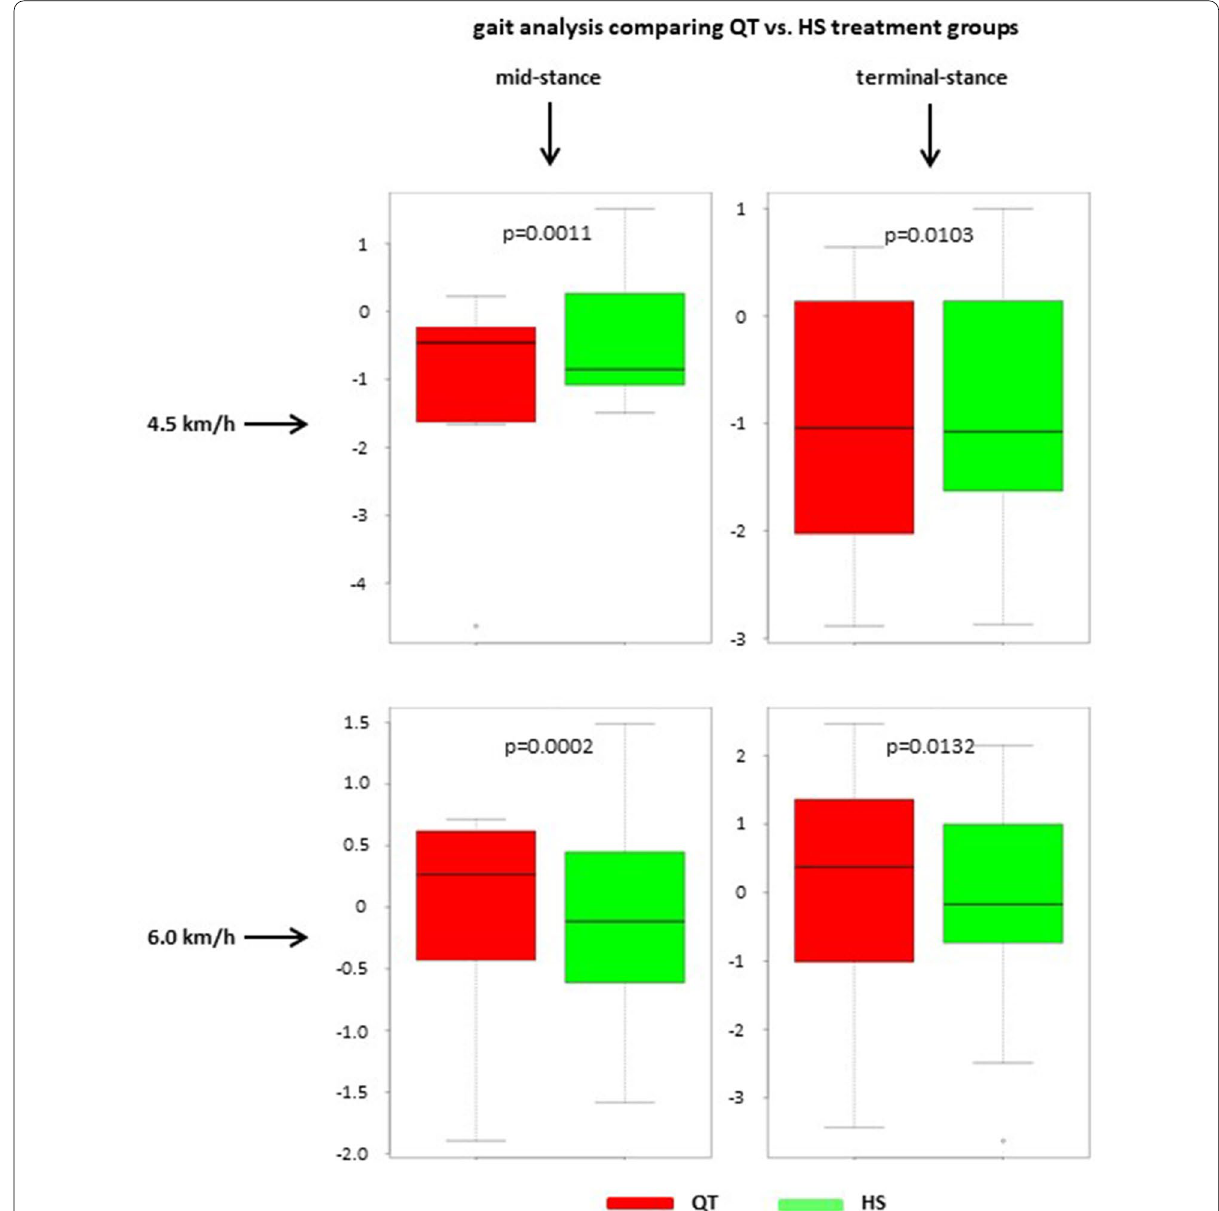
Fig. 2 Boxplot charts comparing the varus–valgus angles between the QT (red) and HS (green) group during mid- and terminal stance at 4.5 km/h and 6.0 km/h. All four boxplot charts show significant equality between the treated knees of both